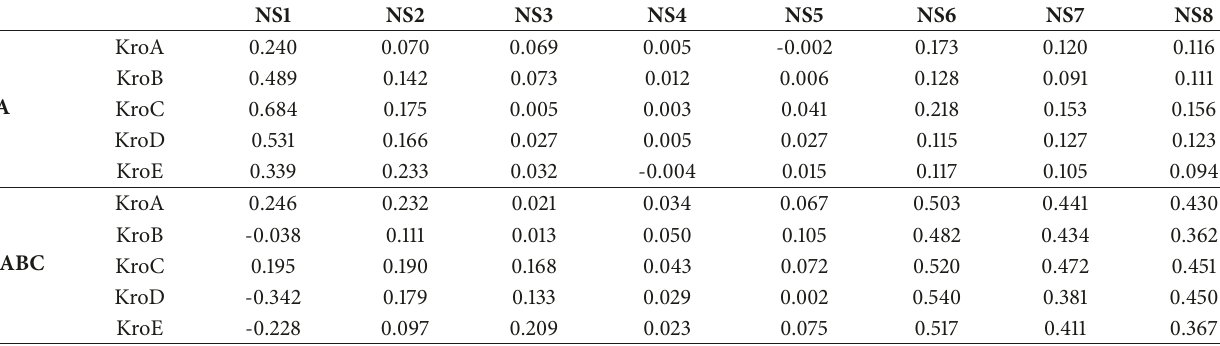
Table 3: Improvement of NS1-NS4 and NS5-NS8.